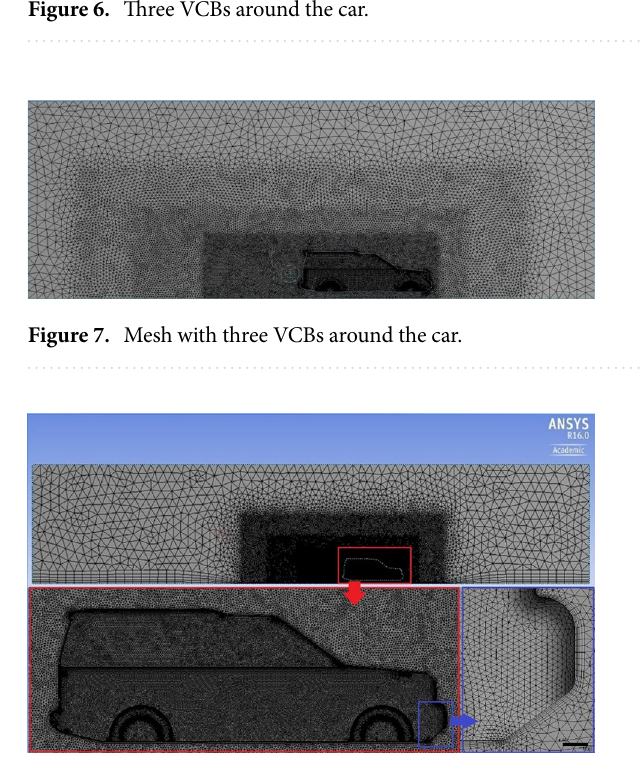
Figure 8. Five inflation layers mesh around the car and over the